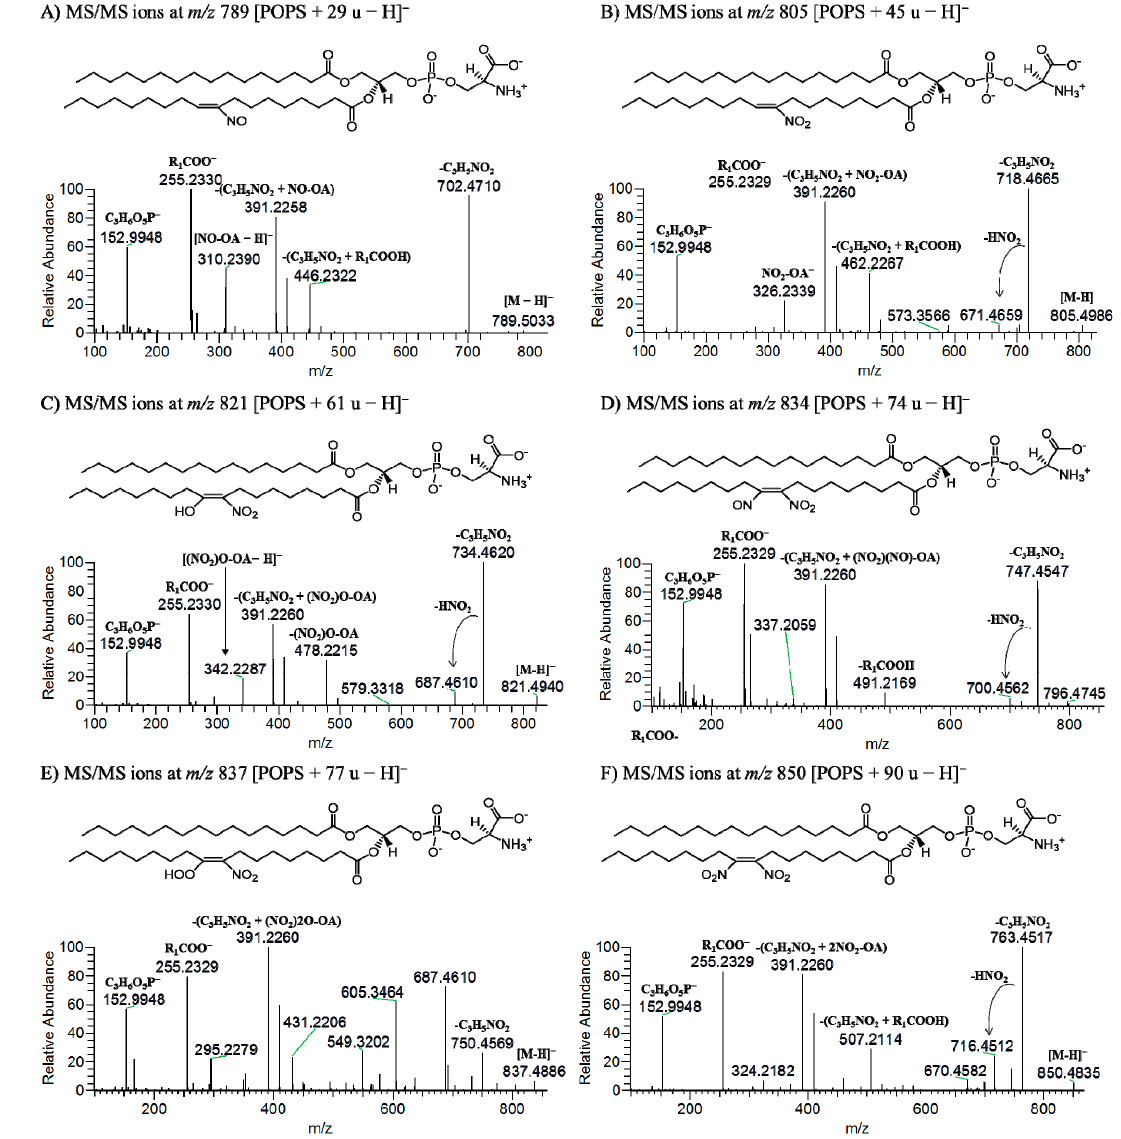
Figure 2. ESI-MS/MS spectra obtained in Q-Exactive Orbitrap of [M − H] − ions of nitroso, nitrated and nitroxidized POPS at m/z 789.5009 ([POPS + 29 u − H] − ) assigned as NO-POPS ( A ), at m/z 805.4980 ([POPS + 45 u − H] − ) assigned as NO 2 -POPS ( B ), at m/z 821.4911 ([POPS + 61 u − H] − ) assigned as (NO 2 )O-POPS ( C ), at m/z 834.4889 ([POPS + 74 u − H] − ) assigned as (NO 2 )(NO)-POPS ( D ), at m/z 837.4868 ([POPS + 77 u − H] − ) assigned as (NO 2 )2O-POPS ( E ), and at m/z 850.4836 ([POPS + 90 u